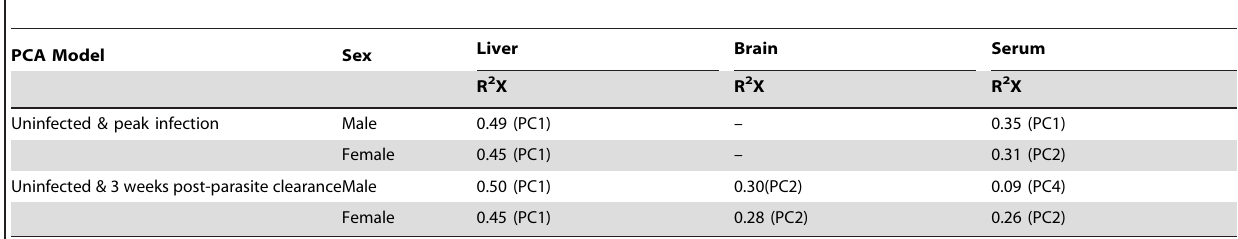
Table 1. The explained variations of the PCA models generated from the liver, brain and serum of the male and female mice.